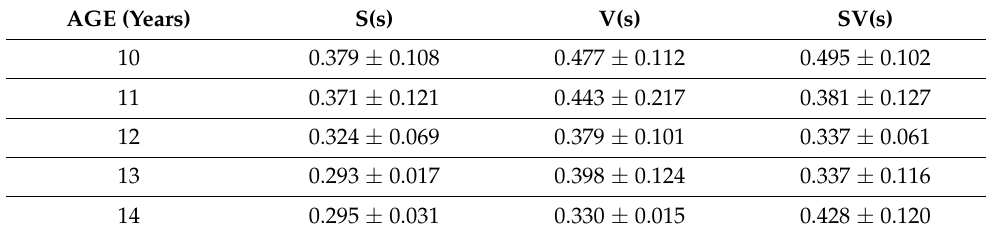
Table 2. Mean values of reaction time in relation to